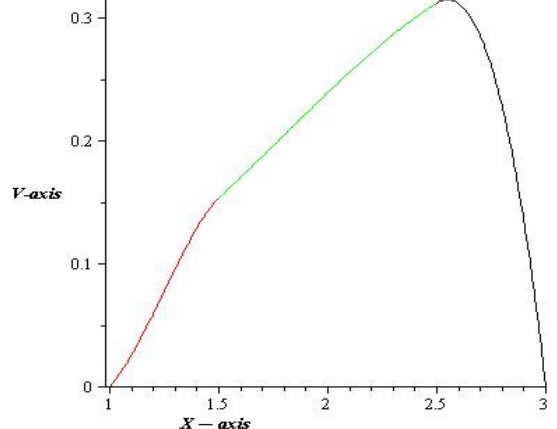
Figure 4. Analytical solution of the problem (c.f. Equation (1)) by HPM for α =